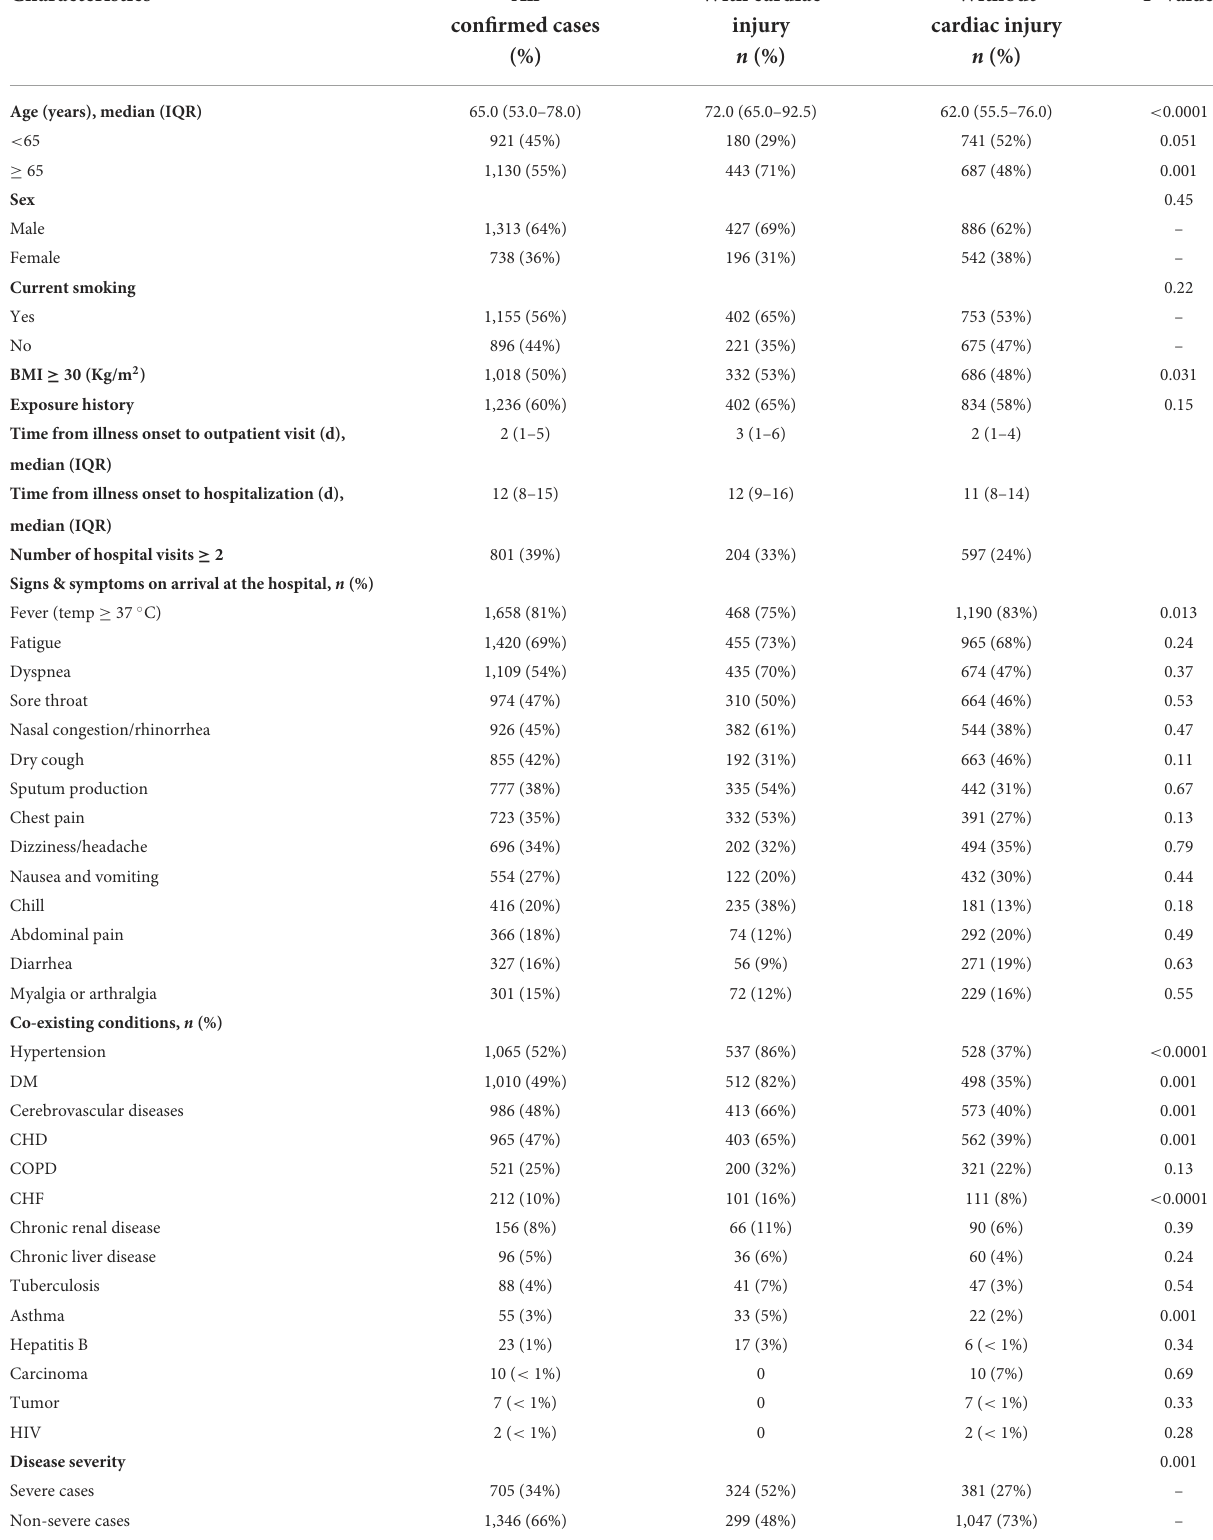
TABLE 1 Baseline demographic and clinical characteristics of COVID-19 patients.